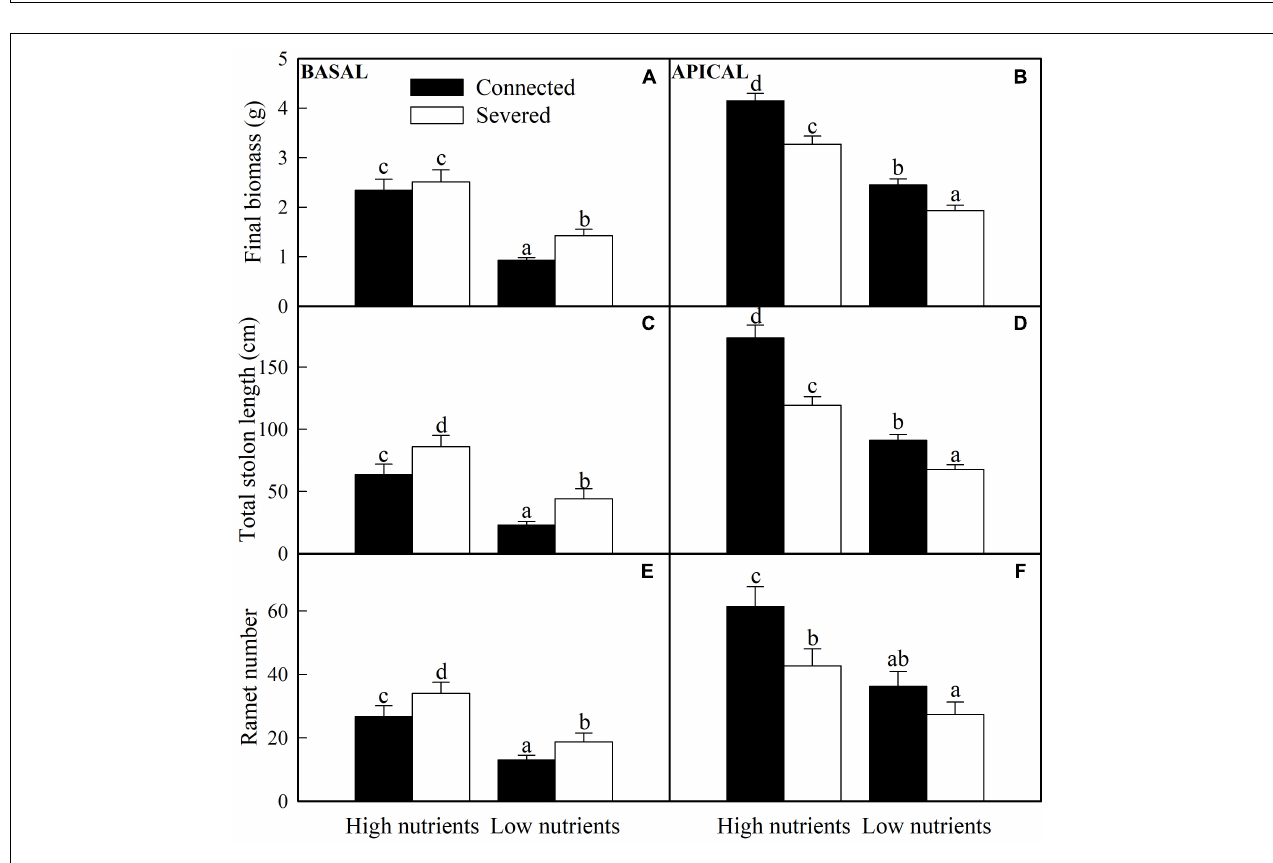
FIGURE 3 | Effects of experimental treatments on the final biomass, total stolon length and ramet number of basal (A,C,E) and apical (B,D,F) ramets of A. philoxeroide . The data indicate the means + SE ( n = 8). The bars sharing the same letter are not significantly different at P =